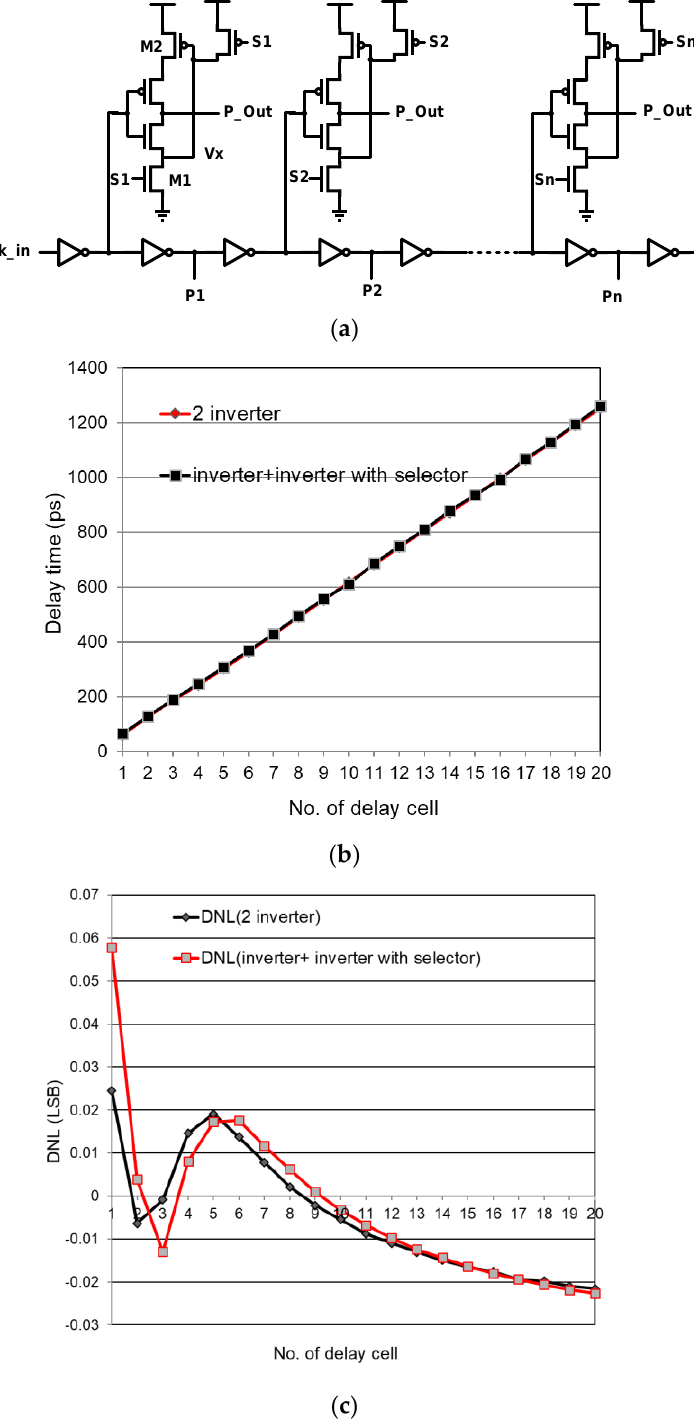
Figure 4. ( a ). Half Delay Line circuit; ( b ) Comparison of the linearity of the delay line of the two architectures; ( c ) DNL analysis results.